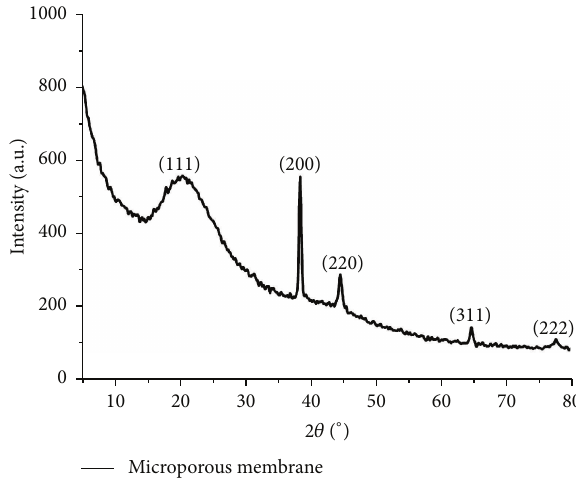
Figure 1: Schematic representation of the experiment. hours after being cleaned 5 times and then dried in vacuo.